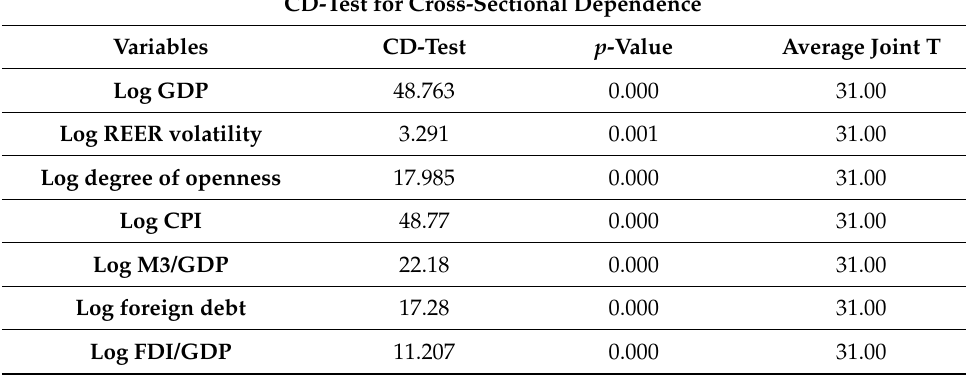
Table 7. Cross-sectional dependence test.